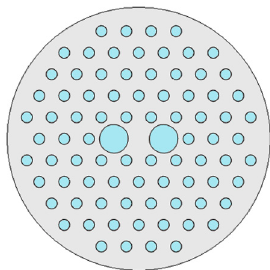
Figure 10. Cross-section of polarization-maintaining PCF 1550-01 used for pressure sensing (Figure curtsy from [56] article).